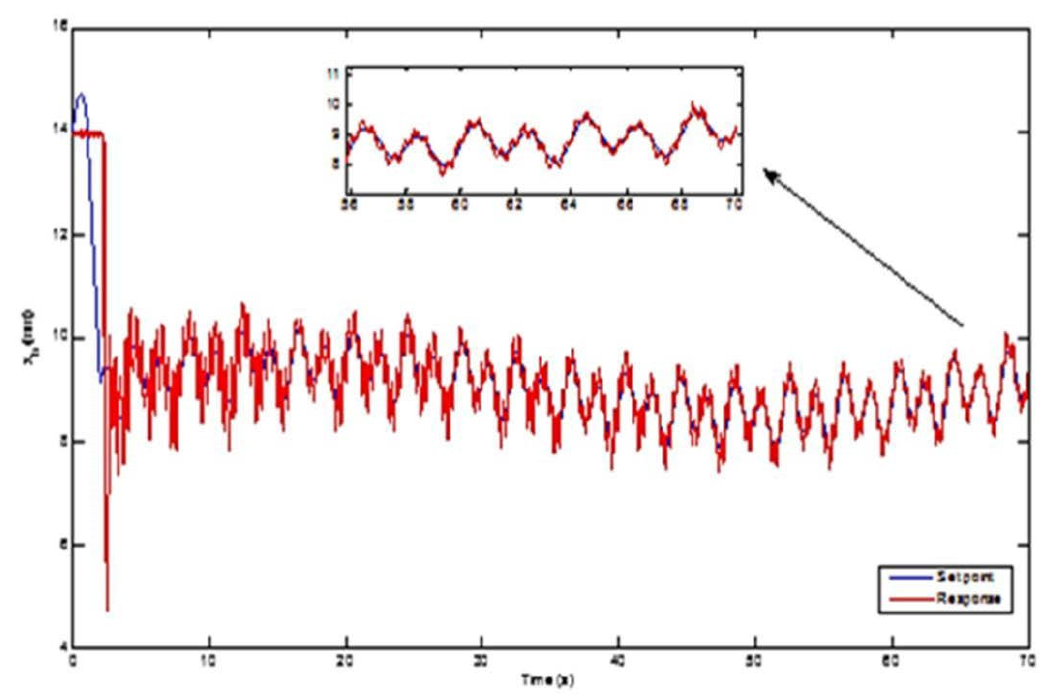
Energies 2021 , 14 , x FOR PEER REVIEW Figure 6. (Top) Multi-sine pattern—Case 1, (bottom) and Multi-sine pattern—Case 2. Figure 6. ( Top ) Multi-sine pattern—Case 1, ( bottom ) and Multi-sine pattern—Case 2.